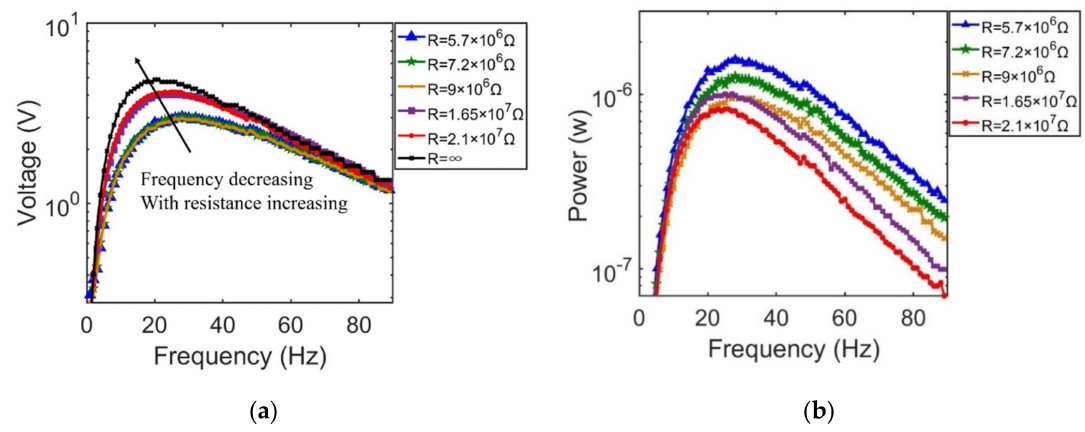
Figure 15. The results of the effects of excitation frequency for the first vibration mode. ( a ) output voltage response for different load resistance; ( b ) average power response for different load resistance.